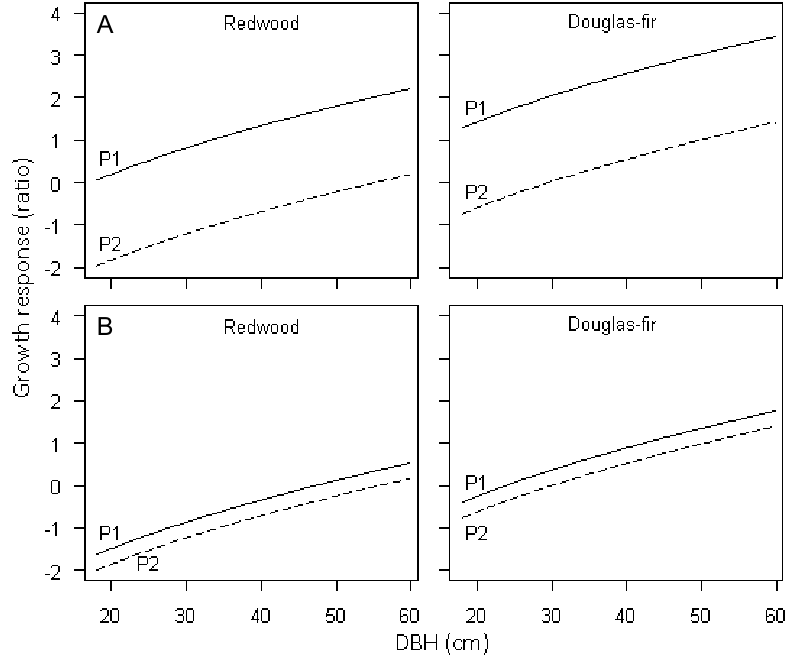
Figure 4. Redwood and Douglas ‐ fir branch growth response (BGR) to increasing dbh for harvest + herbicide ( A ), and herbicide ( B ) plot types in the first 5 ‐ year period (P1) and second 5 ‐ year period (P2) after treatment in Mendocino County, California. The model variable SDI removed was fixed at the means for each plot type to show relationship between BGR and dbh.